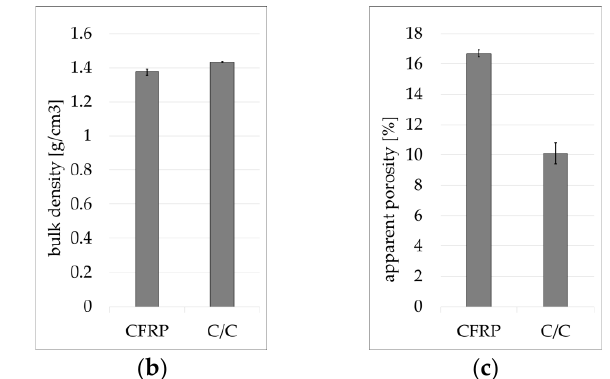
Figure 8. ( a ) Relative change in dimensions and in mass during pyrolysis. ( b ) Bulk density of the CFRP and C/C samples. ( c ) Apparent porosity (volume of open pores related to the bulk volume) of the CFRP and C/C samples.